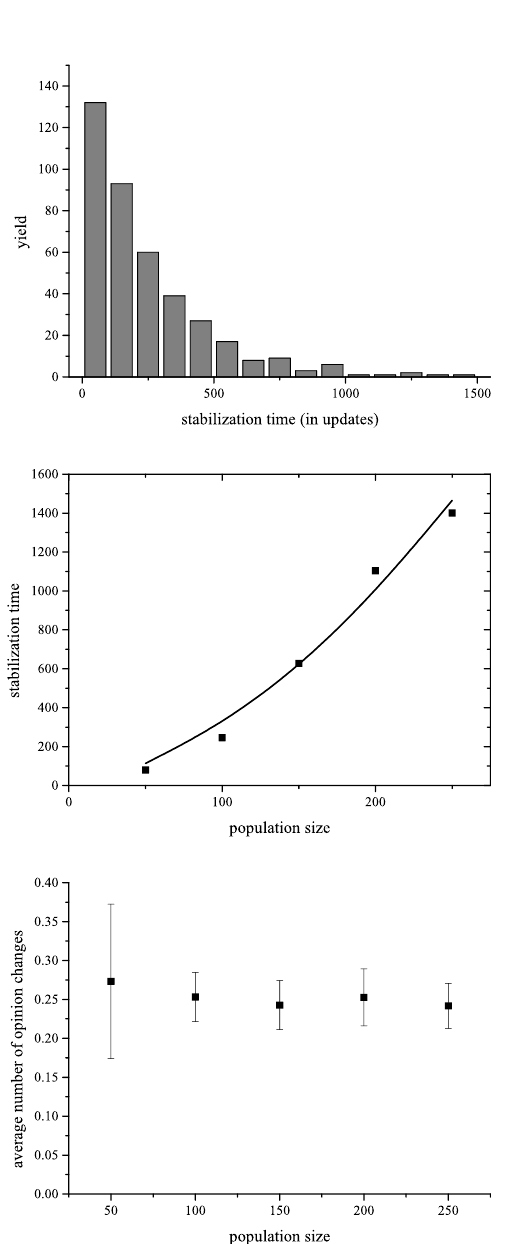
Fig. 9. The size and stabilization e®ects for the PSO-like opinion formation model for the chosen pa- rameter tuple ( f 0:1; 1:25; 0:01; 0:01; 10; 0:1; 10 g ). Upper plot (cid:1)(cid:1)(cid:1) the distribution of stabilization times, middle plot (cid:1)(cid:1)(cid:1) the dependence of average stabilization time on the population size, lower plot (cid:1)(cid:1)(cid:1) the average rate of opinion